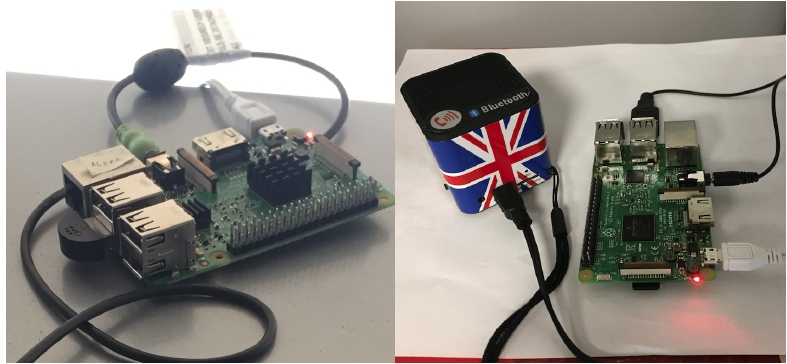
Figure 4. Sensor nodes with the USB microphone and speaker